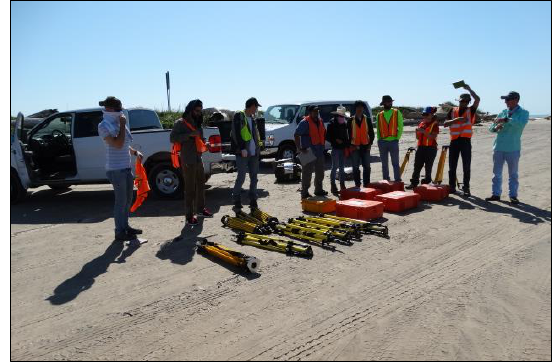
Figure 2. Heavy equipment sets used for mapping the Freeport beach and dune area with the conventional terrestrial laser scanning (TLS) surveying